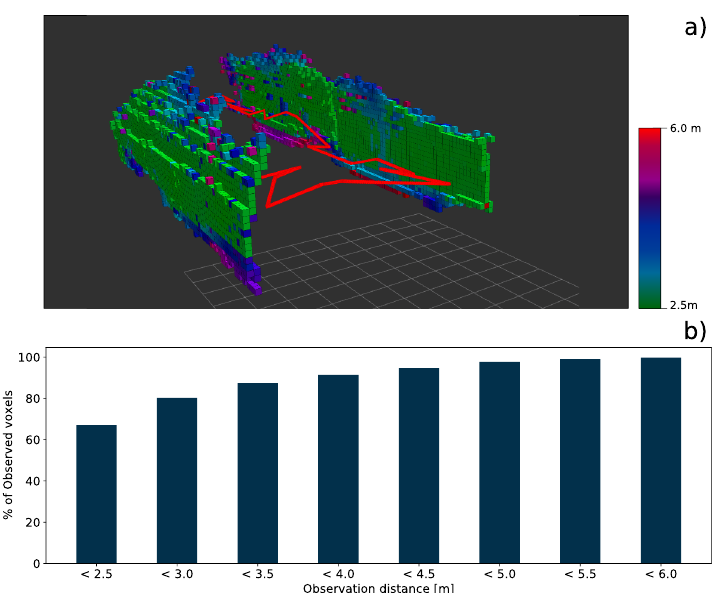
Figure 11. ( a ) Autonomous inspection path and the 3D-reconstructed voxel map together with a color indication of the distance at which each voxel has been sensed by the on-board inspection sensors. ( b ) Accumulated percentage of voxels detected at different observation